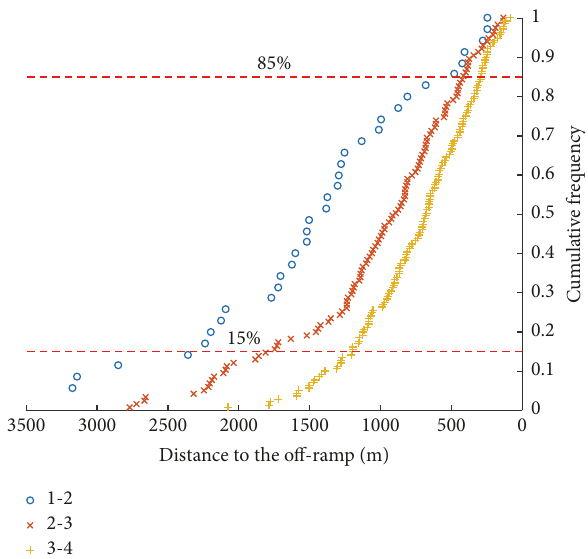
Figure 6: Cumulative frequency graph of lane-changing longitudi- nal position on different lanes.